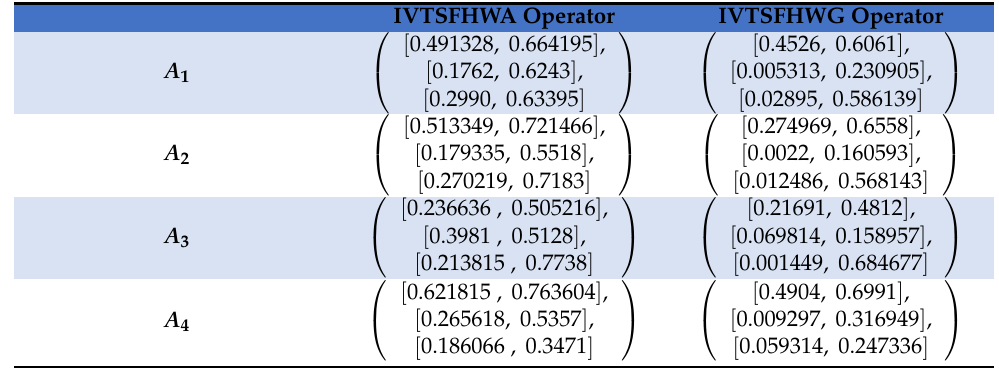
Step 2. The IVTSFHWA and IVTSFHWG operators are applied to get aggregated information, given as in Table 2. Note that while using IVTSFHWA and IVTSFHWG operators, we take q = 5, γ = 2 and w = ( 0.2, 0.5, 0.25, 0.05 ) T . Table 2. Aggregated values of IVTSFHWA and IVTSFHWG operators.